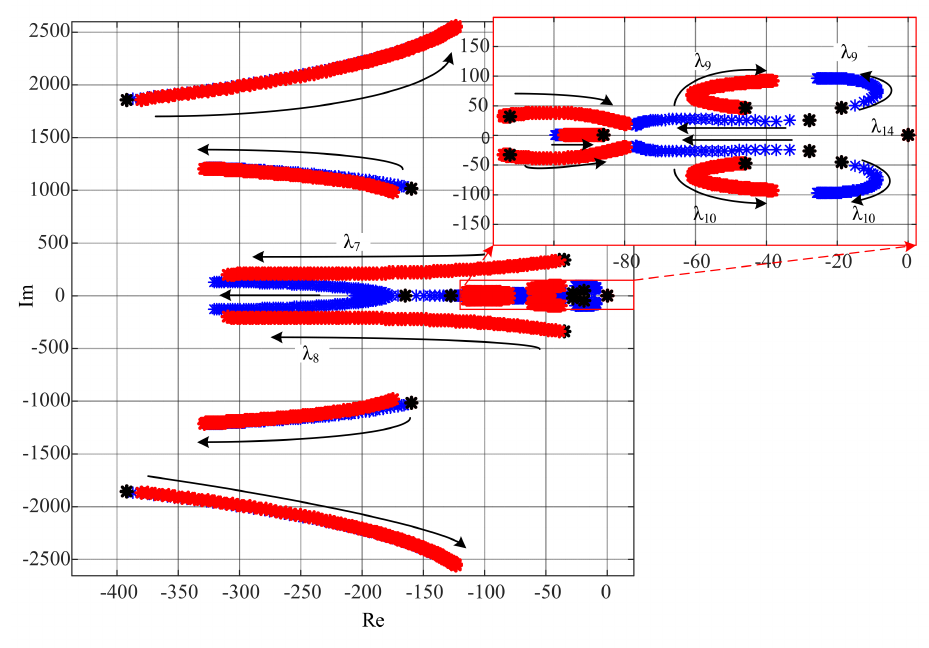
Figure 10. Sensitivity of system eigenvalues under variation of DVC control bandwidth.